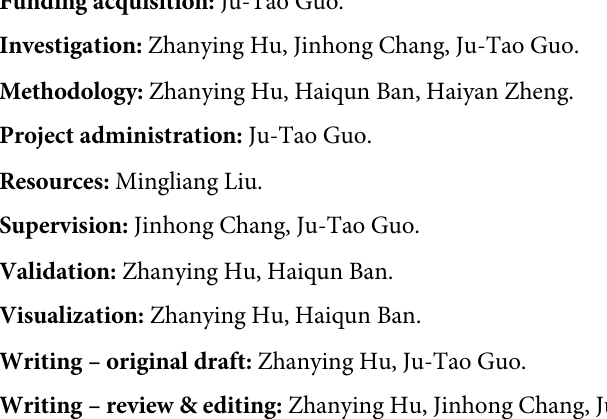
and statistical analysis for Figure panel 2B, 2D, 3C, 3D, 3E, S2C, S2D and